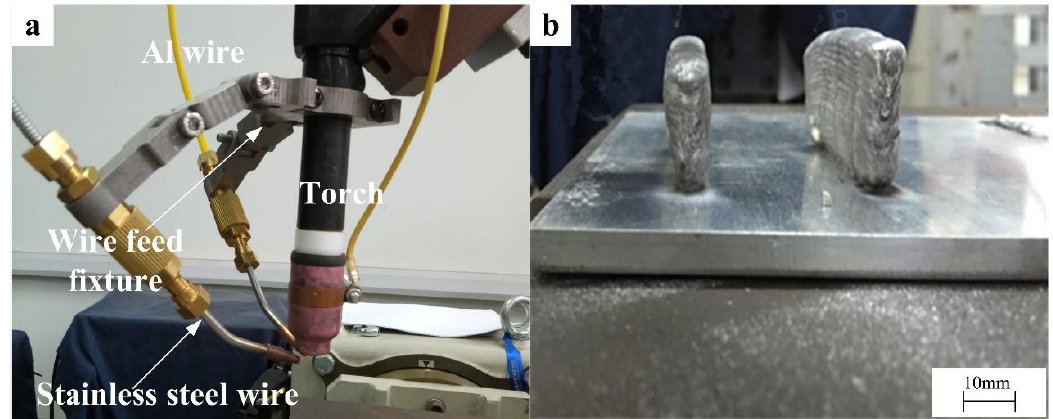
Figure 1. ( a ) Robot system and ( b ) representative molded product.